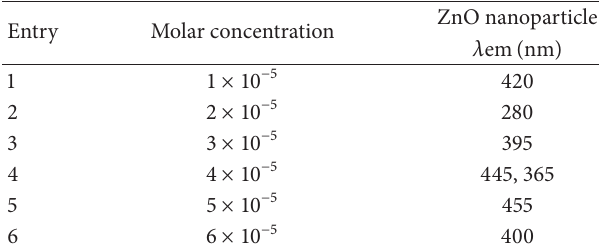
Figure 4: U-V spectrum of ZnO nanoparticles. Table 4: Fluorescence data ZnO in methanol at different molar concentrations.